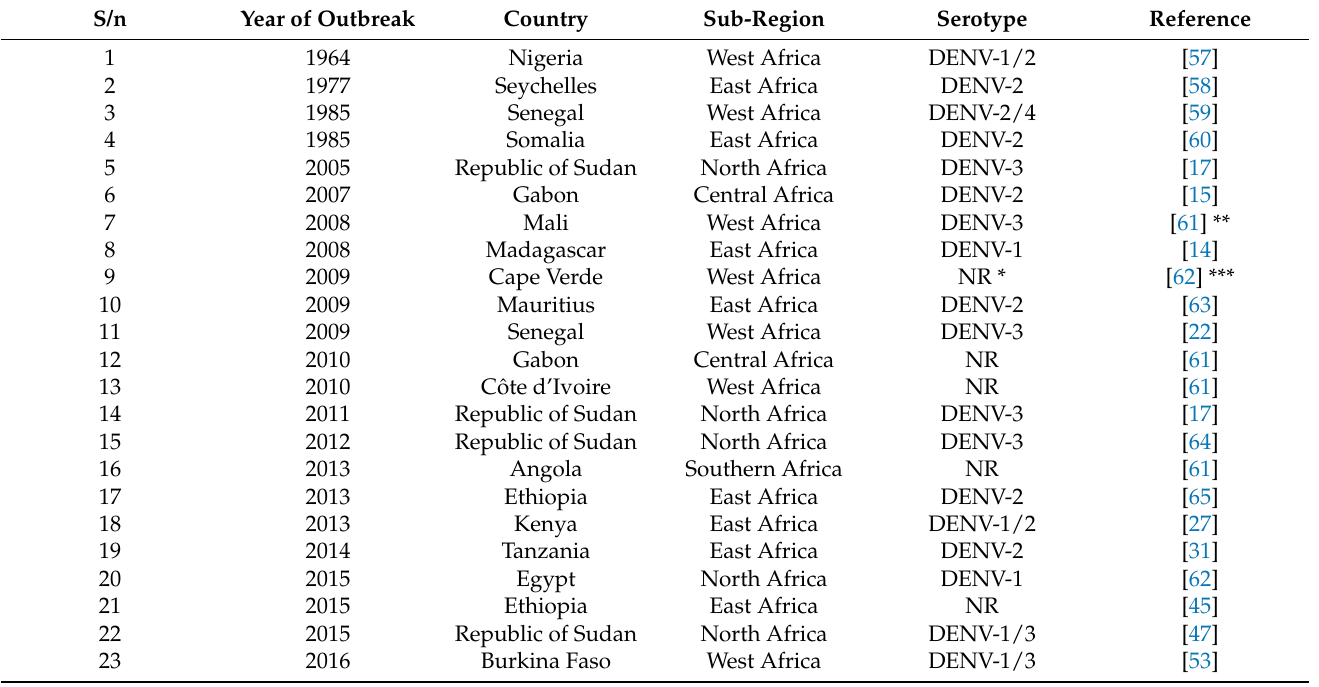
Table 2. Dengue virus outbreaks in Africa by year, country, sub-region, and serotype, 1964–2020.